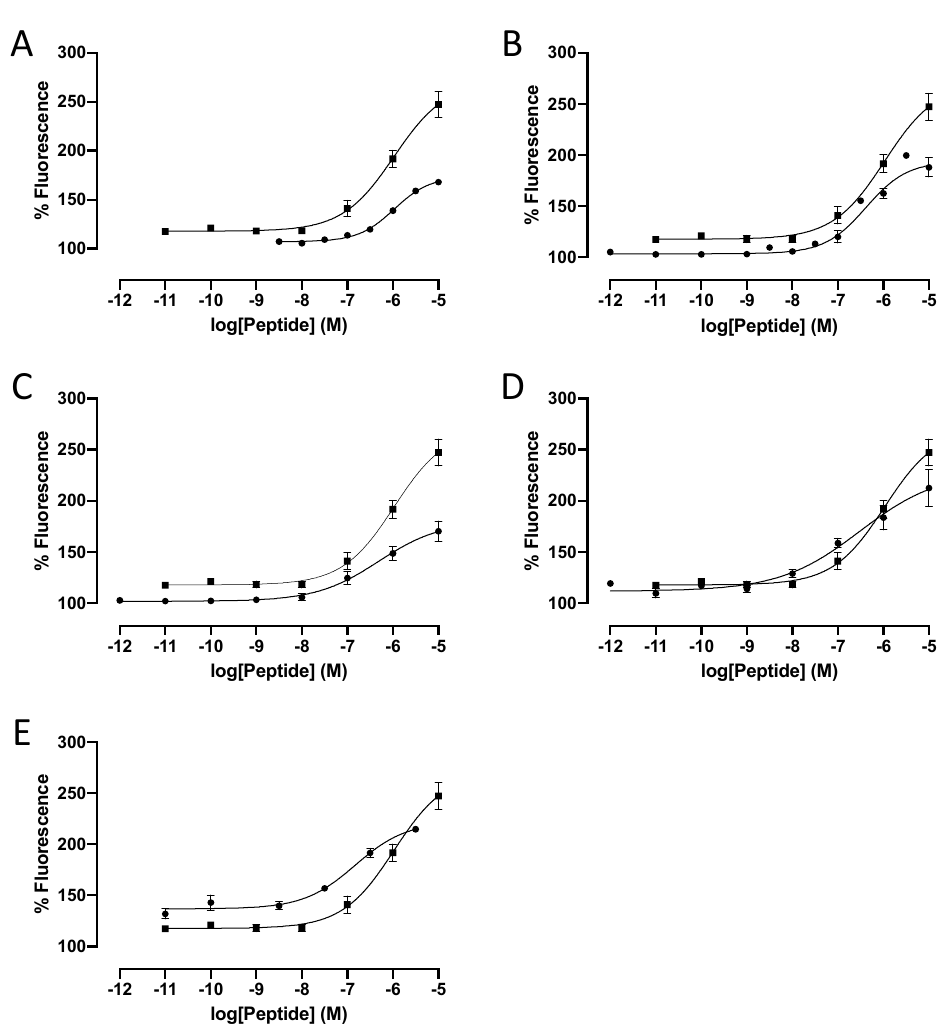
Figure 3. Effect of graded concentrations of Phe-modified 26RFa (20 − 26) analogs on basal [Ca 2+ ] i mobi- lization in G α 16 - h QRFPR-transfected CHO cells. Prototype dose–response curves of 26RFa (20 − 26) (LV- 2021, 1 , closed square, ( A – E )) and its analogs (closed circles) [ pt BuPhe 26 ]26RFa (20–26) (LV-2238, 13 , ( A )), [Pcp 26 ]26RFa (20–26) (LV-2193, 16 , ( B )), [ p NO 2 Phe 26 ]26RFa (20–26) (LV-2194, 19 , ( C )), [Tic 22 ]26RFa (20– 26) (LV-2211, 28 , ( D )) and [ N Phe 22 ]26RFa (20–26) (LV-2058, 31 , ( E )). Data are mean ± SEM of triplicate. The EC 50 calculated from these representative dose–response curves were 1069 nM for 1 (LV-2021), 1076 nM for 13 (LV-2238), 416 nM for 16 (LV-2193), 489 nM for 19 (LV-2194), 305 nM for 28 (LV- 2211) and 149 nM for 31 (LV-2058).